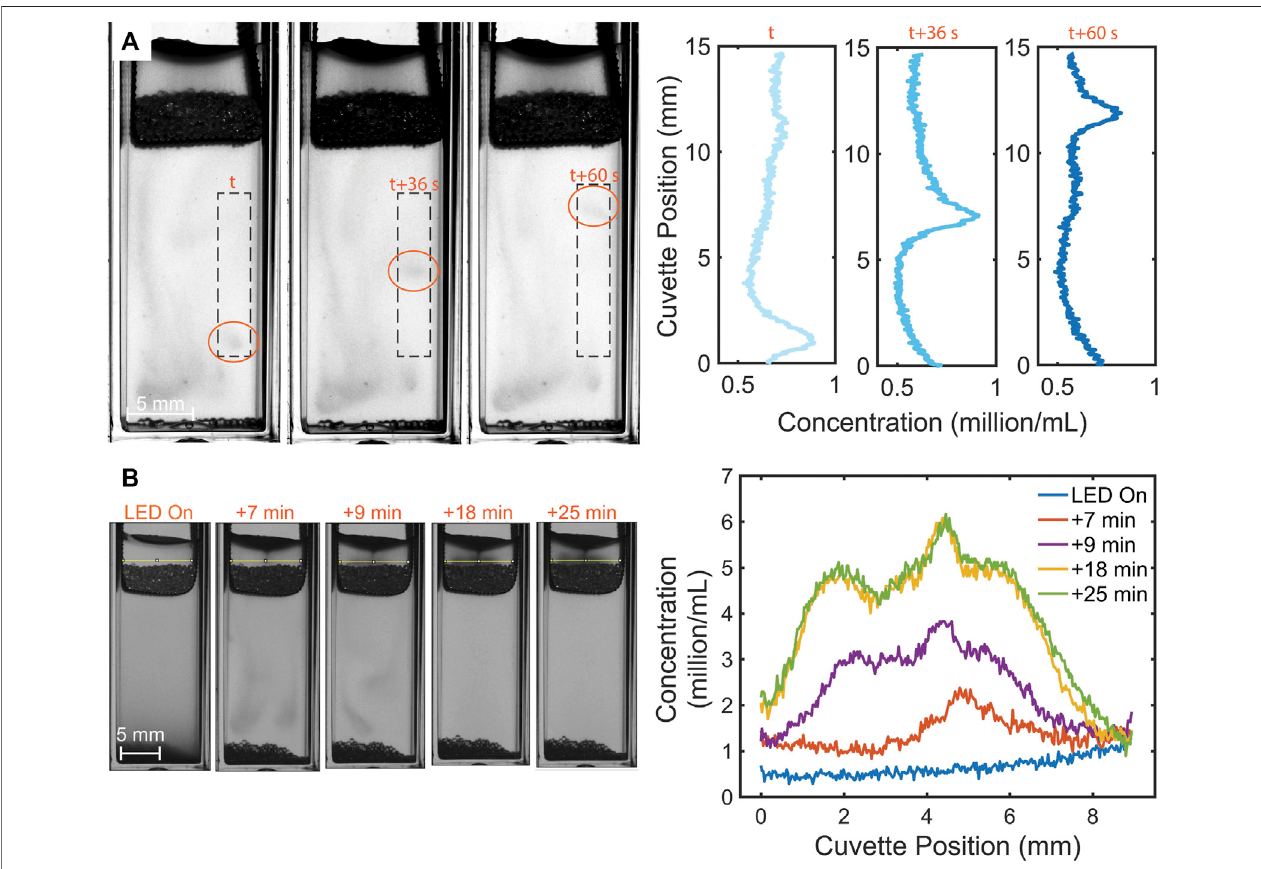
FIGURE 5 | Photogyrotactic dynamics of swimming algae in the mesh + beads case. (A) Stills of the algal clusters in the lower region moving upwards as waves with speed ∼ 180 μ m/s. (B) Lateral expansion of the trapped algal plume-cloud formed in the upper harvest region. Its density is seen to increases over time as it